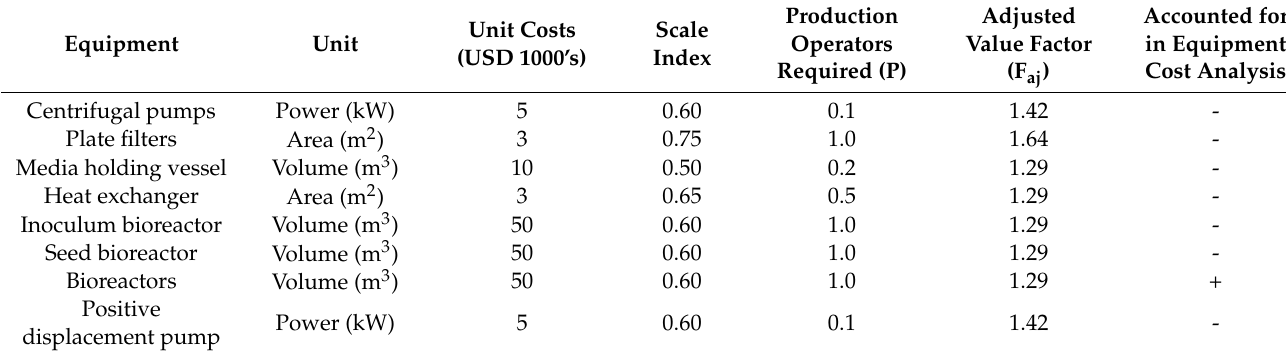
Table A9. Potential industrial scale equipment for ACBM production.